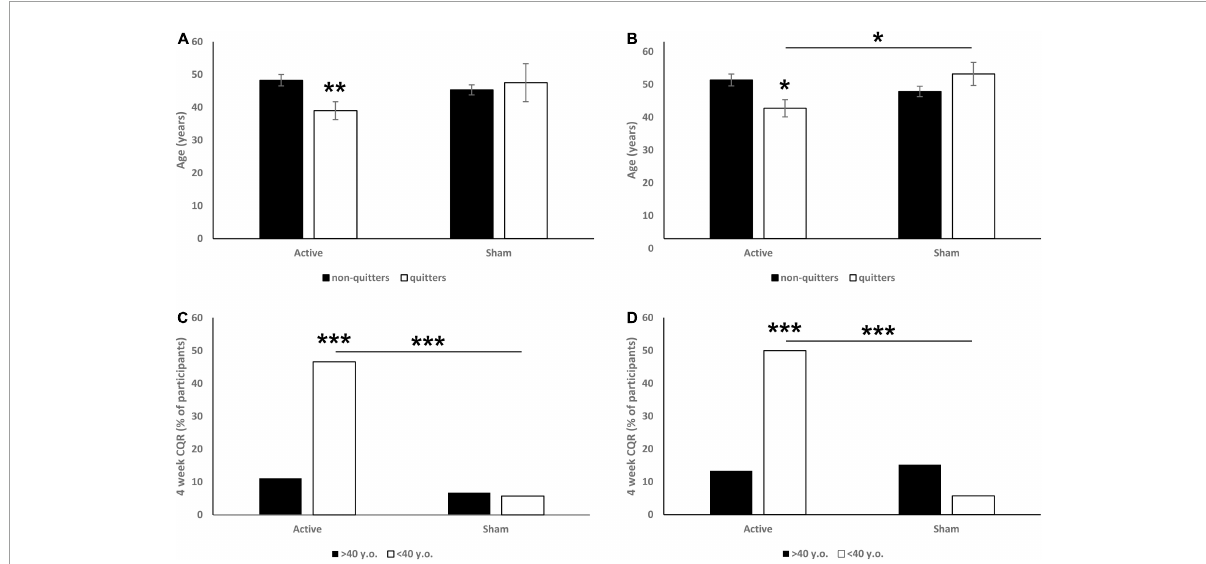
FIGURE1 Effects of participant’s age ( A: 6 weeks CQR data, B: 18 weeks CQR data) and being older or younger than 40 years old ( C: 6 weeks CQR data, D: 18 weeks CQR data) on CQR. On panels (A,B) data are presented as mean ± SEM. On panels (C,D) data are presented as % of participants. * p < 0.05, ** p < 0.01, *** p <